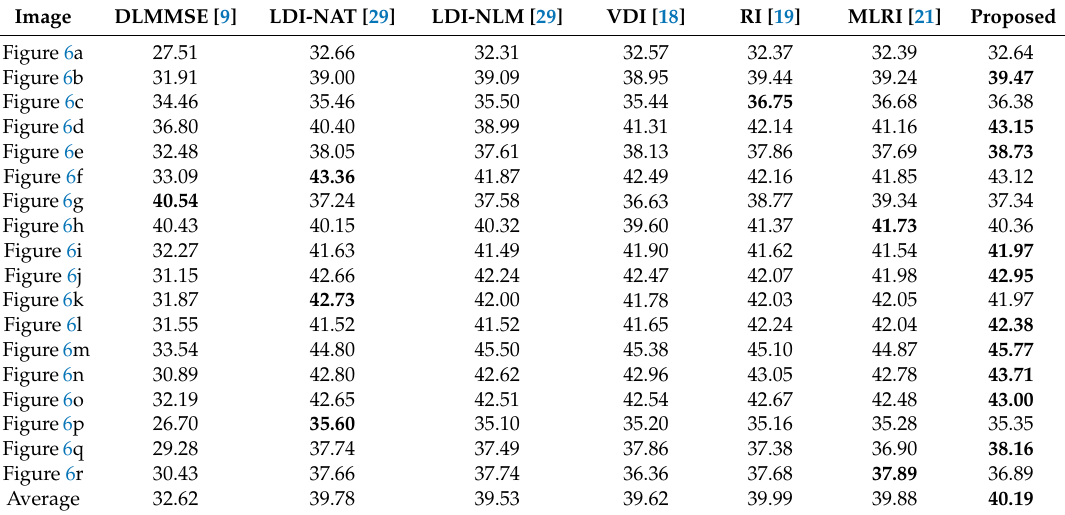
Table 2. The PSNR (dB) of G components for the MCMaster images.